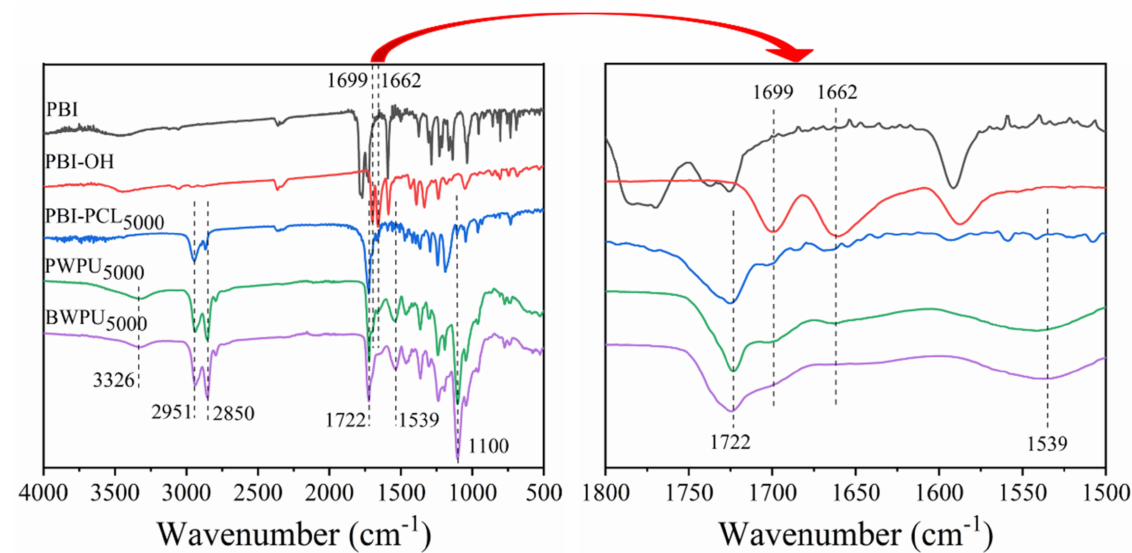
Figure 1. FTIR spectra of PBI, PBI-OH, PBI-PCL 5000 , PWPU 5000 and BWPU 5000